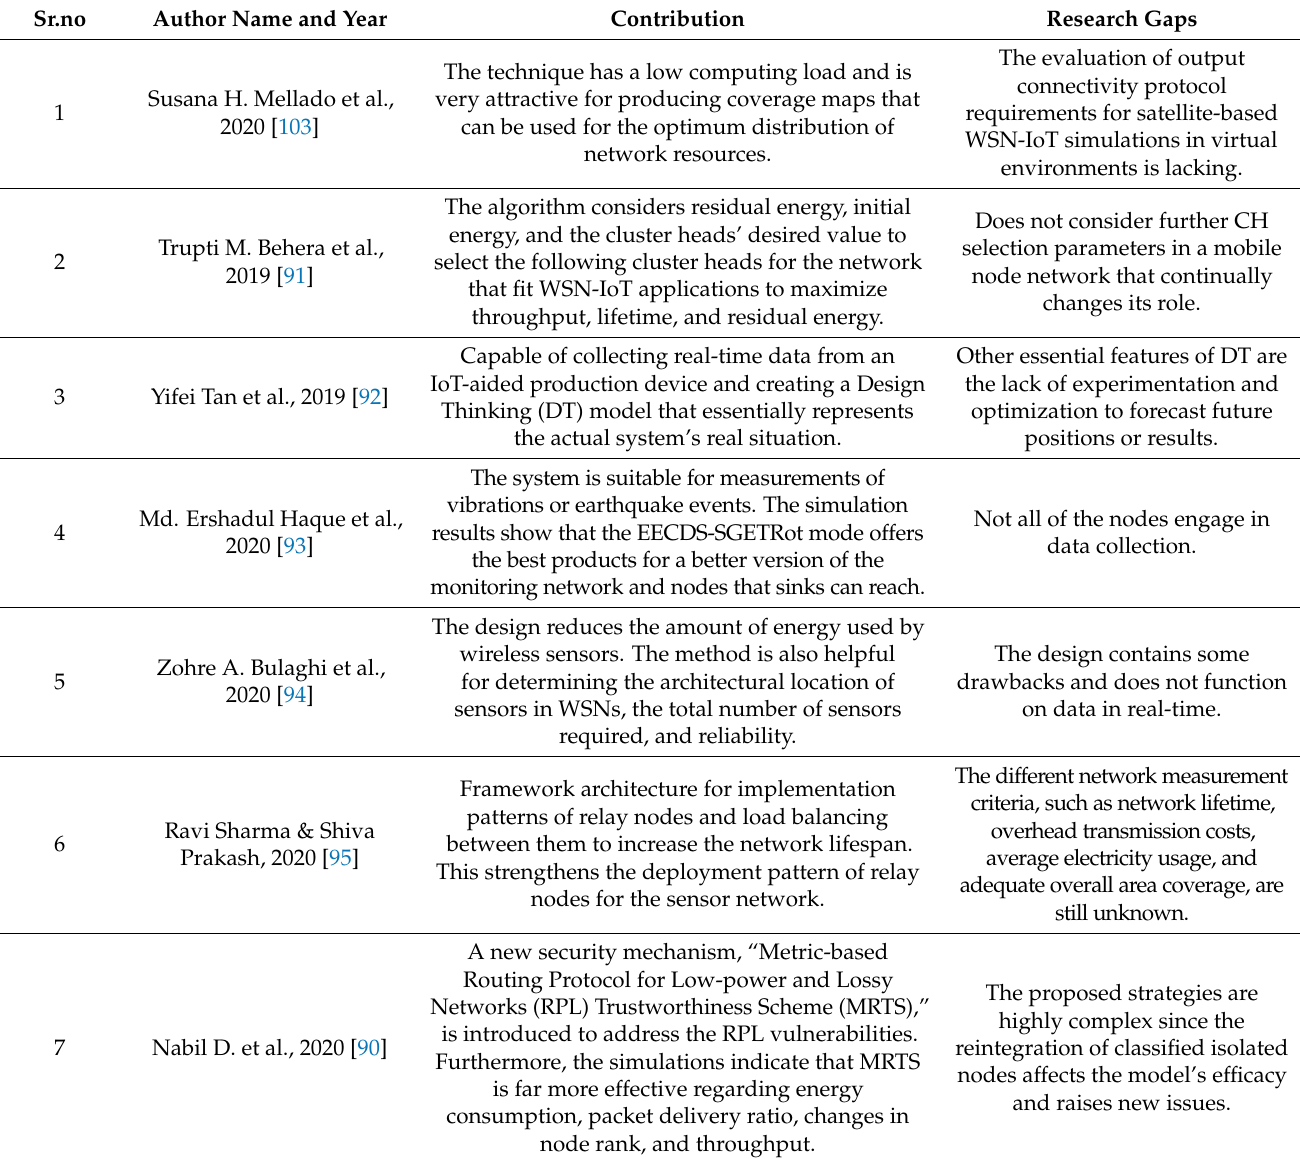
Table 5. Current work conducted in the domain of WSN-IoT and the research